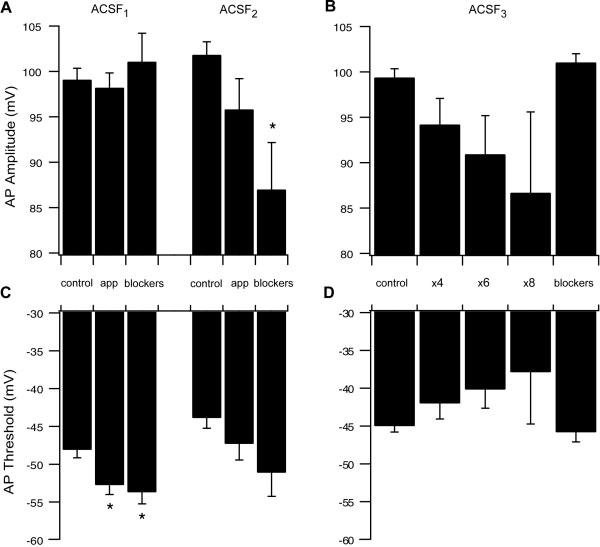
Effect of slice excitation on action potential amplitude and threshold.AP amplitude and threshold were measured under control conditions, ACSF application and addition of synaptic blockers. A, AP amplitude with ACSF1 (left) and ACSF2 (right). B, AP amplitude with various concentrations of ACSF3. C, AP threshold with ACSF1 (left) and ACSF2 (right). D, AP threshold with various concentrations of ACSF3.